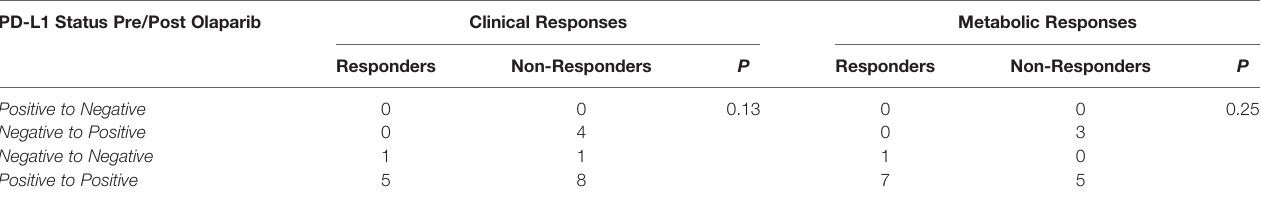
TABLE 3 | PD-L1 status changes in olaparib responders and non-responders. PD-L1 Status Pre/Post